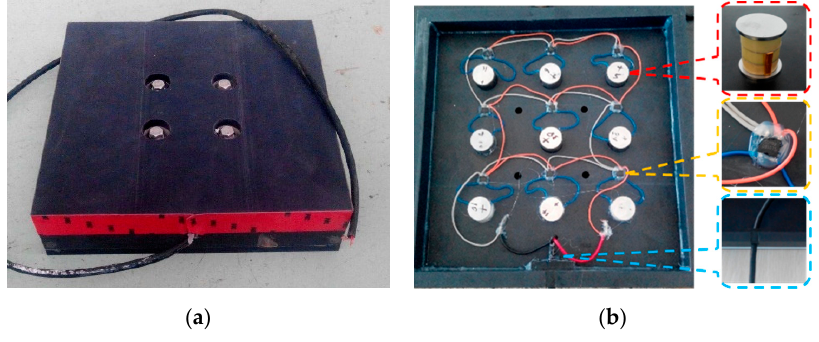
Figure 2. Illustration of the PEH: ( a ) outward appearance; ( b ) internal structure.